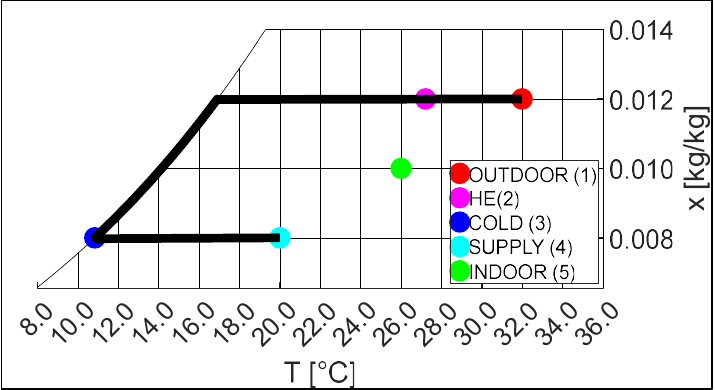
Figure 3. Transformations in an HVAC system with traditional dehumidification.